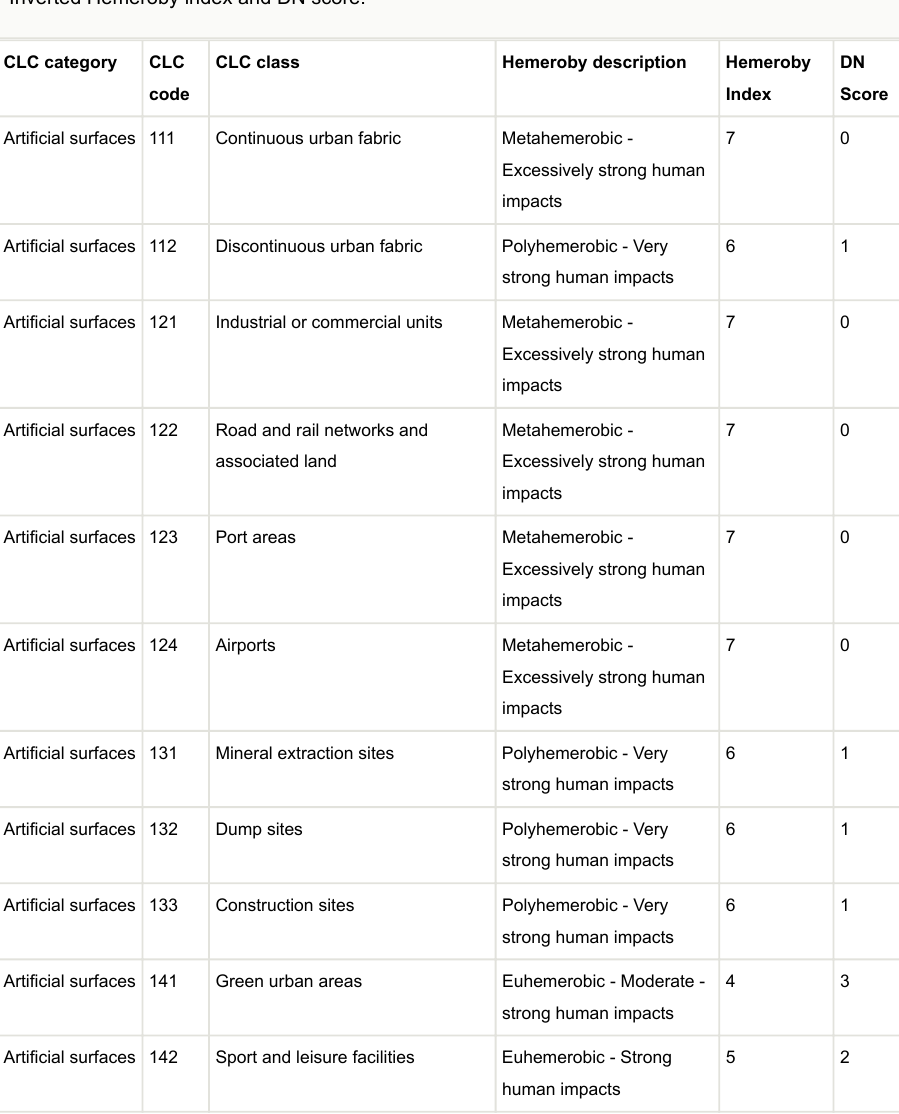
Table 2. Inverted Hemeroby index and DN